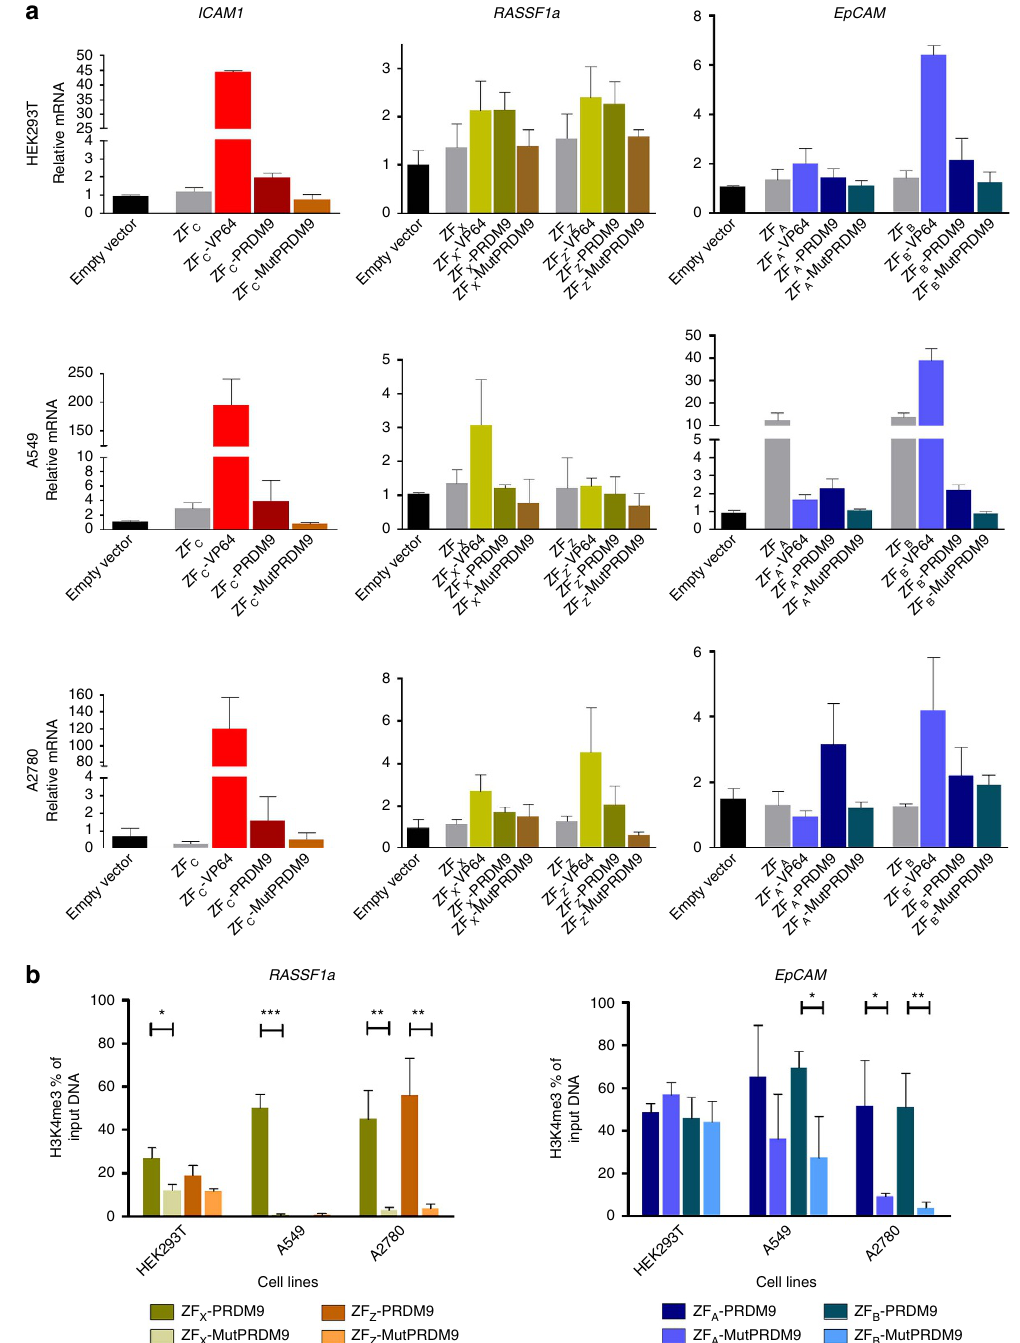
Figure 2 | Local induction of H3K4me3 activates transcription of endogenous genes from promoter regions using zinc-finger proteins. ( a ) Relative messenger RNA (mRNA) expression of ICAM1 , RASSF1a and EpCAM in HEK293T, A549 and A2780 cells determined by qRT–PCR, induced by the indicated ZF fusion protein after retroviral transduction, the letter of each ZF corresponds to the same region where a gRNA binds at the promoter. ( b ) H3K4me3 ChIP–qPCR enrichment at the promoter region of EpCAM and RASSF1a in HEK293T, A549 and A2780 after retroviral transduction with ZF-PRDM9 and ZF-MutPRDM9 (two-tailed unpaired t -test, * P o 0.05, ** P o 0.01, *** P o 0.001). n ¼ 3 independent experiments; error bars ±